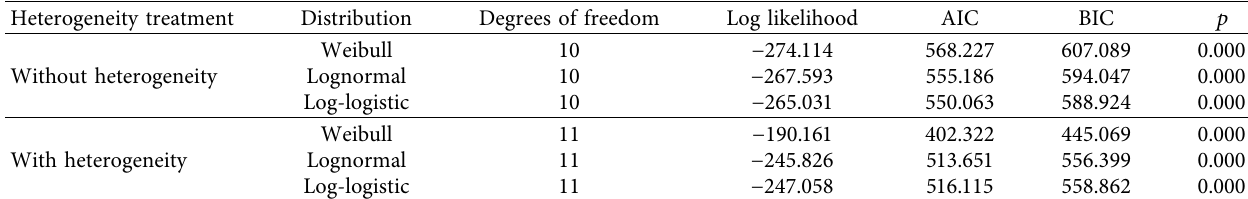
Table 2: Comparison of fit statistics of the models.